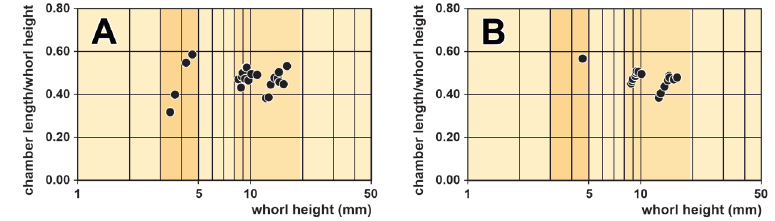
Fig. 70. Trilacinoceras filix sp. nov., chamber length/whorl height of holotype MB.C.30557 (Neben & Krueger Coll.) from Rerik (Ostsee) (Mecklenburg-Vorpommern). A . Empirical data. B. Three data point